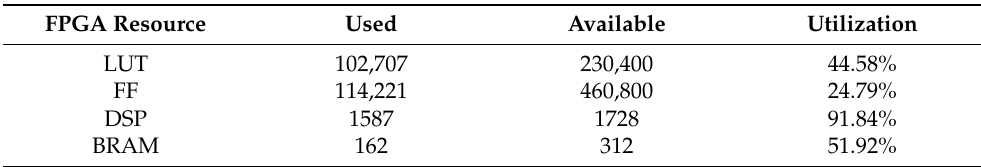
Table 6. FPGA Resource utilization for the CNN accelerator. FPGA Resource